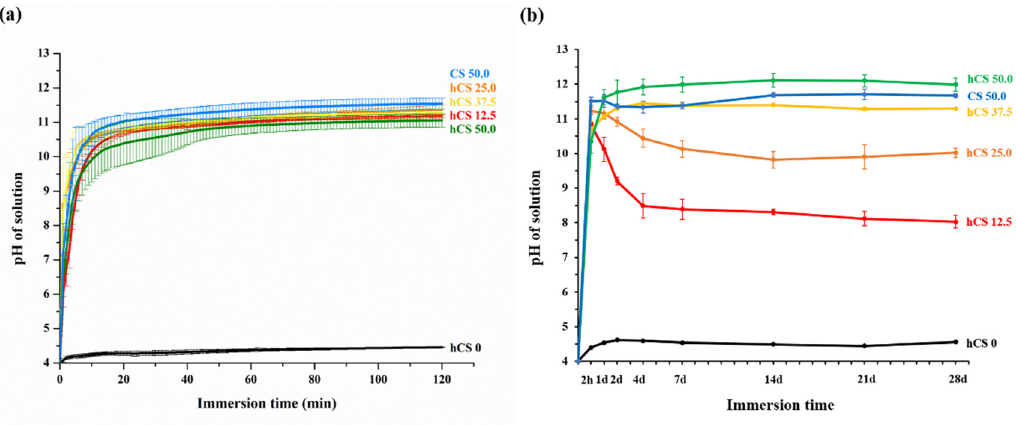
Figure 4. The pH value of the lactic acid solution recorded after the specimens were immersed for 120 min ( a ) and prolonged periods of time from 2 h to 28 d ( b ). Each value represents the average of 5 repeated measurement, and the error bars indicate the standard deviation of the average values (average ± standard deviation; n = 5).